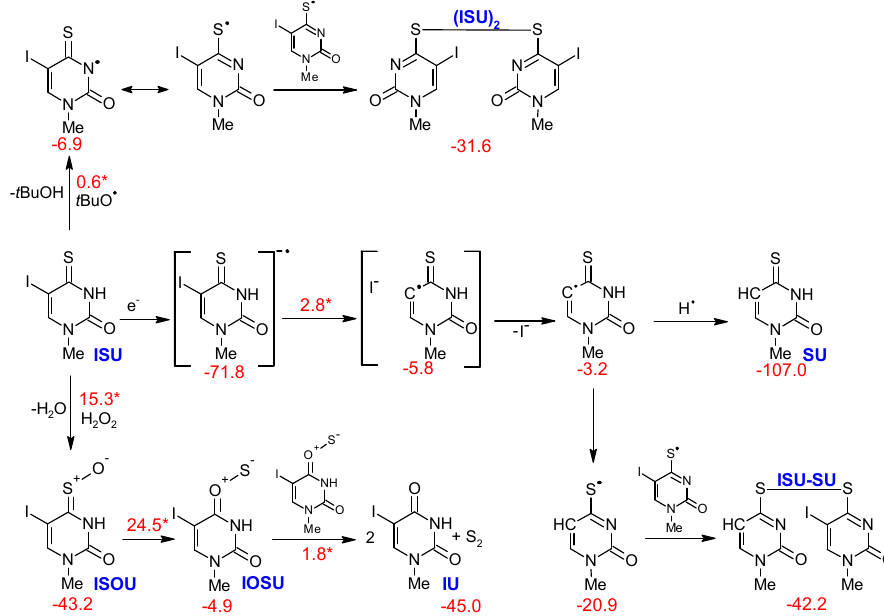
Scheme 2. The calculated pathways for the formation of irradiation products. The values in red, shown in kcal/mol, correspond to the thermodynamic stimuli and kinetic barriers (marked with asterisks; for the transition state (TS) structures see Supplementary Materials, Figures S6–S10) calculated as the difference between free energies of the given species and the corresponding